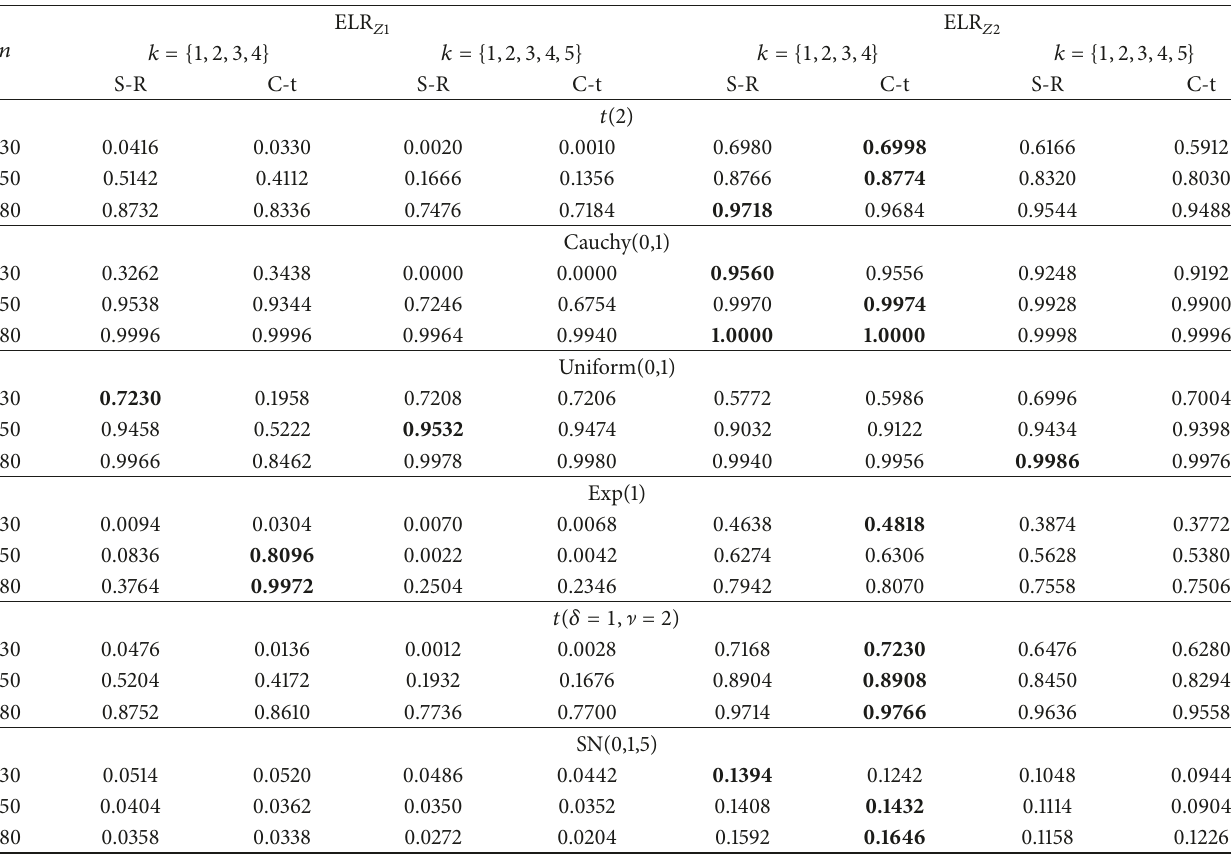
Table 4: A numerical assessment on power using the Shiryaev-Roberts (S-R) and CUSUM-type (C-t) statistics for the proposed tests (ELR 𝑍1 and ELR 𝑍2 ) with increased moment constraints at 𝛼 = 0.05